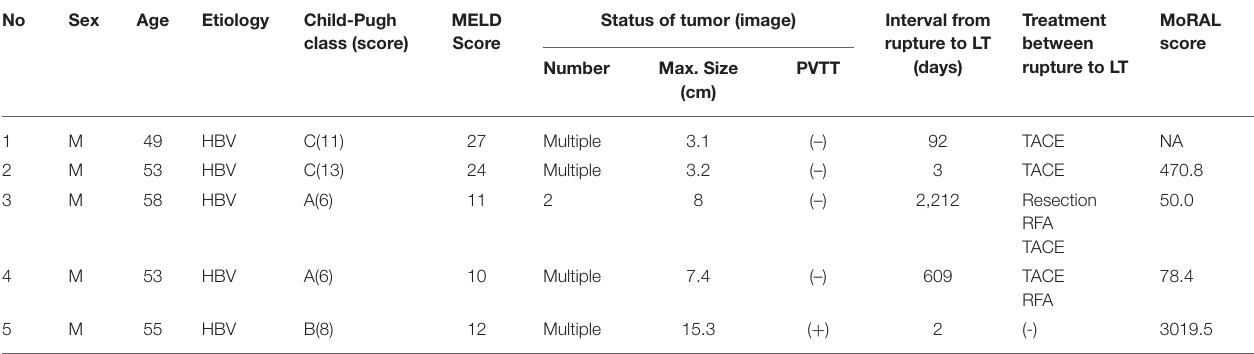
TABLE 1 | Preoperative data of patients.